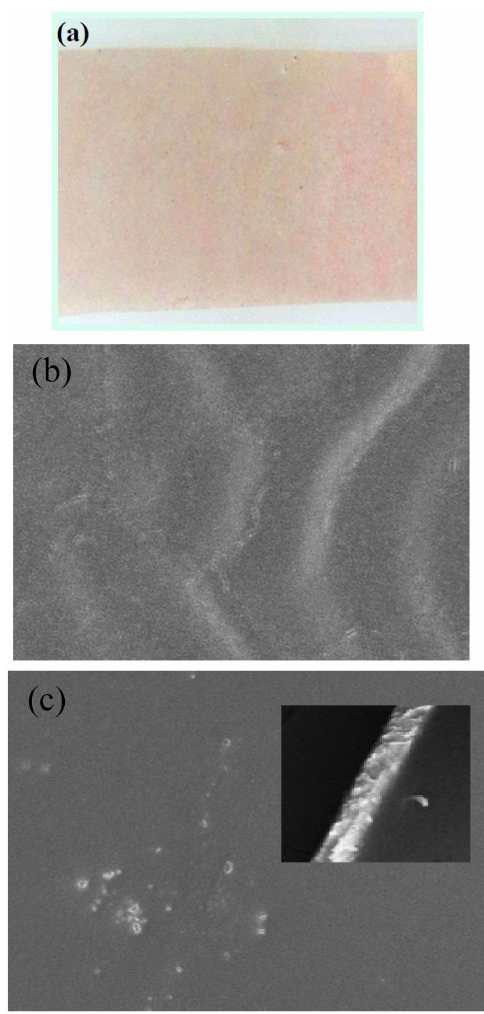
Figure 1: (a) Digital image of the synthesised BTFMO-PVA nanocom- posite film, (b) FESEM image of the pristine PVA, (c) FESEM image of the film sample (inset shows the cros-sectional